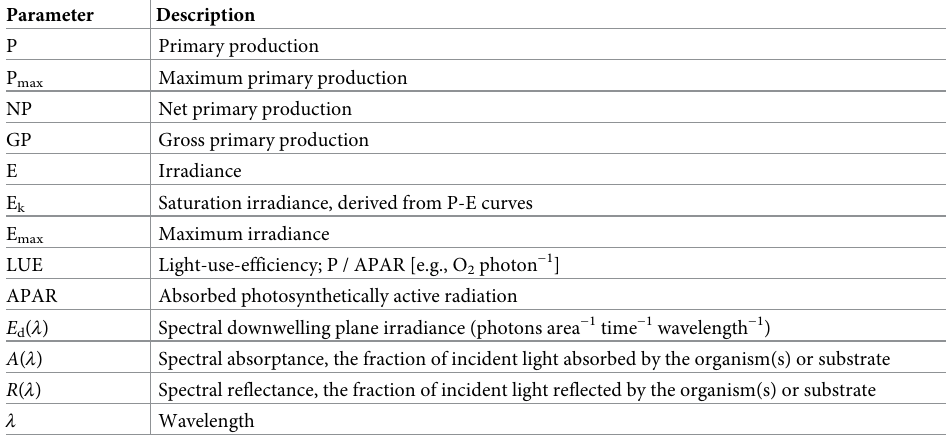
Table 1. Description of parameters used or mentioned in the